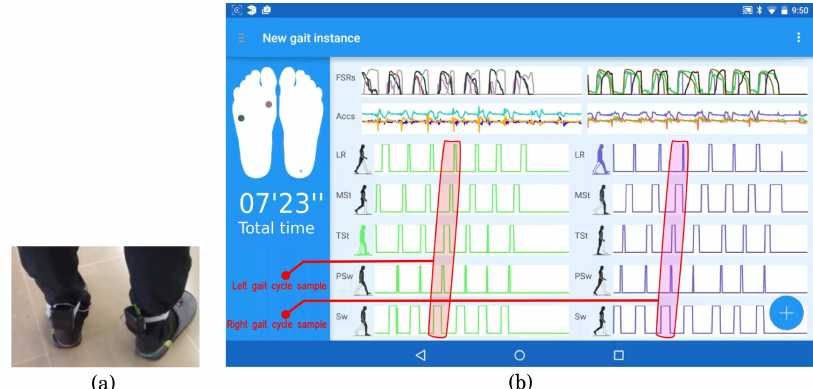
Figure 8a. For each subject, three separate trials were stored, each of them consisting of 10 gait cycles for each foot. The first and the last gait cycles in the trials were discarded. As we said in Section 3.3, the start and the end of the walking forward sequence do not properly represent the subject’s gait, due to poor stability (in the case of the beginning) and gait deceleration (at the end of the walking sequence).